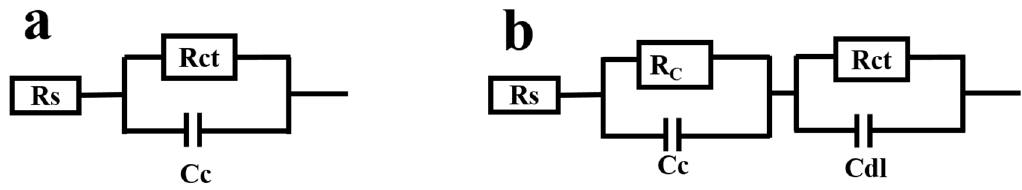
Figure 6. The electrical equivalent circuit of the capacitive loop for electrochemical impedance spectroscopy (EIS) without inhibitor ( a ) and the electrical equivalent circuit in di ff erent concentration of inhibitors at 25 ◦ C ( b ) .